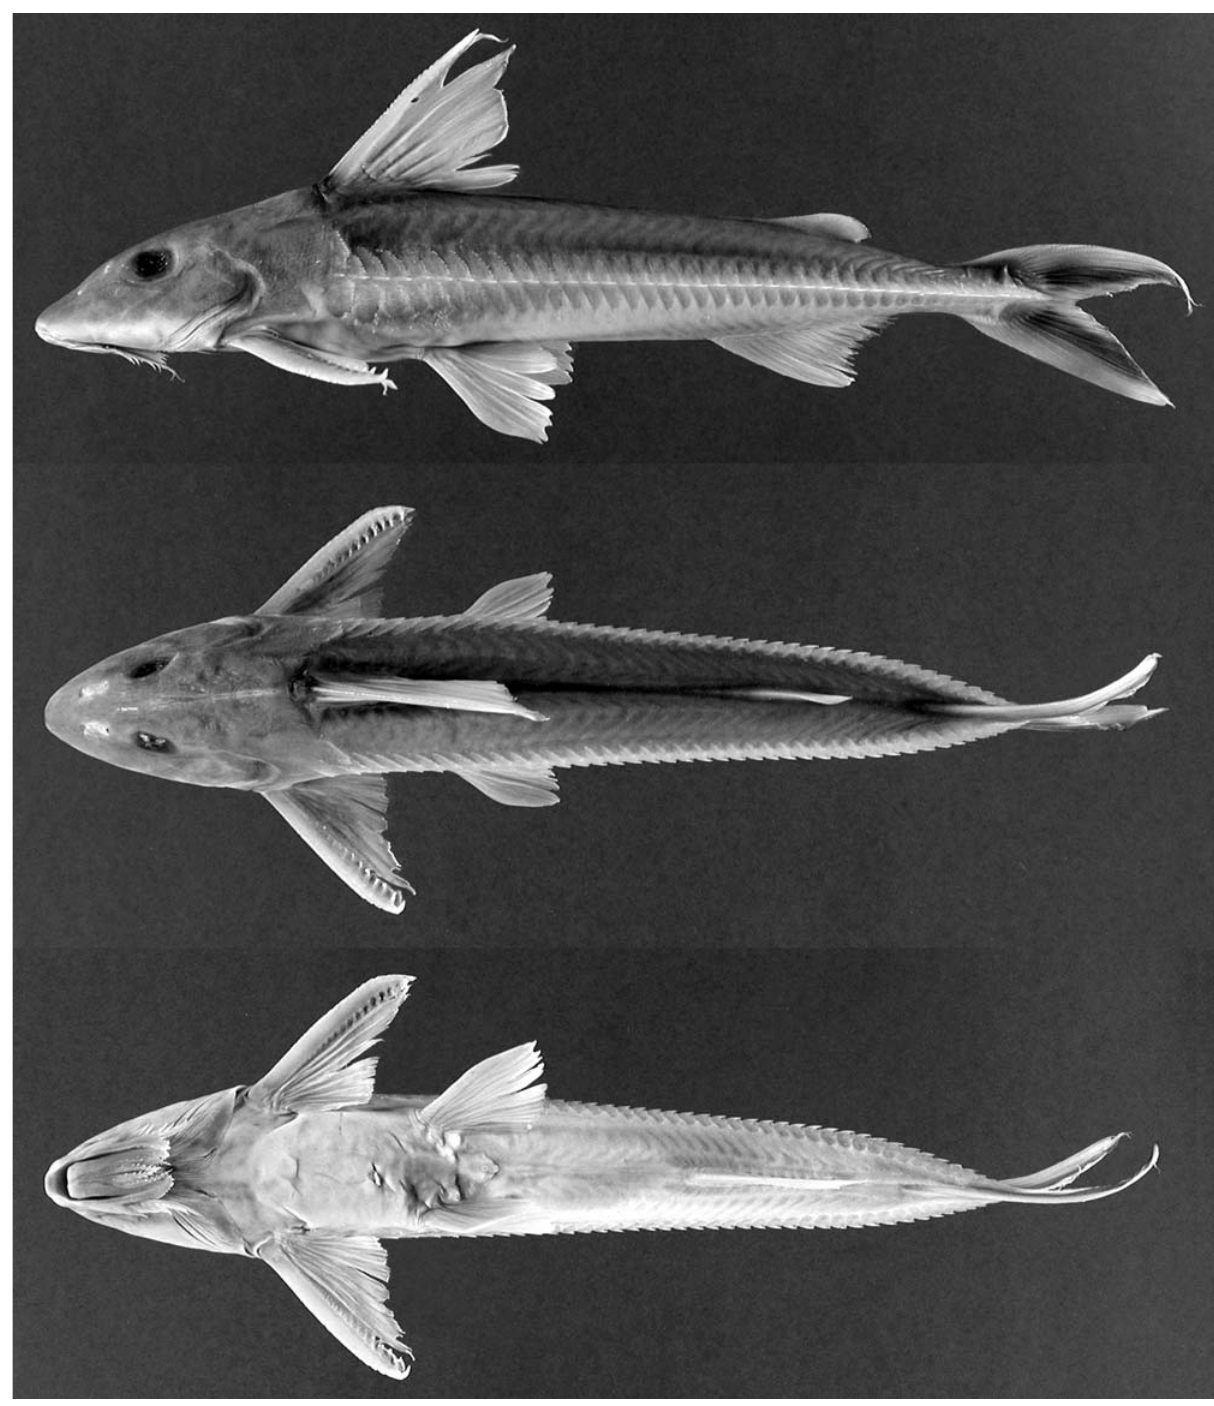
Fig. 21. Leptodoras rogersae , holotype USNM 226307 (SL 180 mm), río Orinoco (Atlantic dr.), Palua just below mouth of río Caroni, Bolivar,